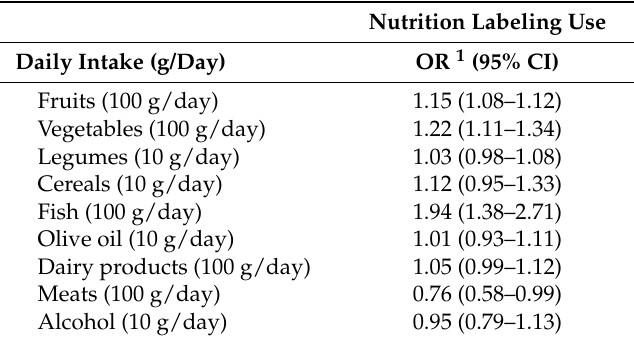
Table 4. Relationship between food components of Relative Mediterranean Diet Score (rMED) and nutrition labelling use in participants aged 17–35 years from the DiSA-UMH study, Spain ( n =